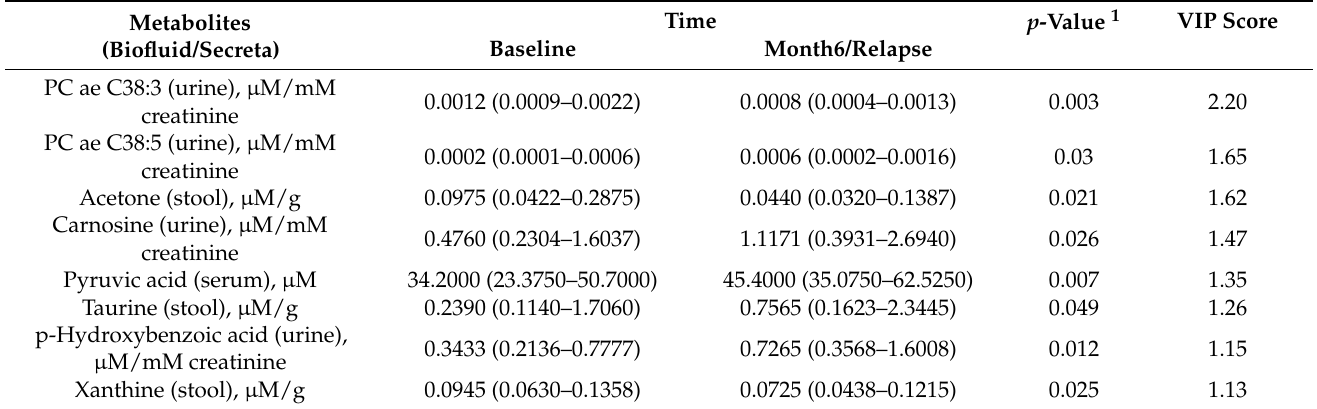
Figure 5. Partial least squares discriminant analysis plot comparing the metabolomic profiles of patients in the two diet groups from baseline to month 6 or time of relapse. While patients in the Canada’s Food Guide diet ( A ) did not have any significant changes in their metabolome ( p = 0.93, R 2 = 0.26, Q 2 = − 0.38), patients randomized to the Anti-Inflammatory Diet ( B ) group showed a significant change in their metabolomic profiles from baseline to the end of the intervention ( p = 0.01, R 2 = 0.74, Q 2 = 0.27). Table 2. Concentration of major metabolites in different biofluids responsible for the discrimination of metabolome from baseline to month 6 or time of relapse in the anti-inflammatory diet